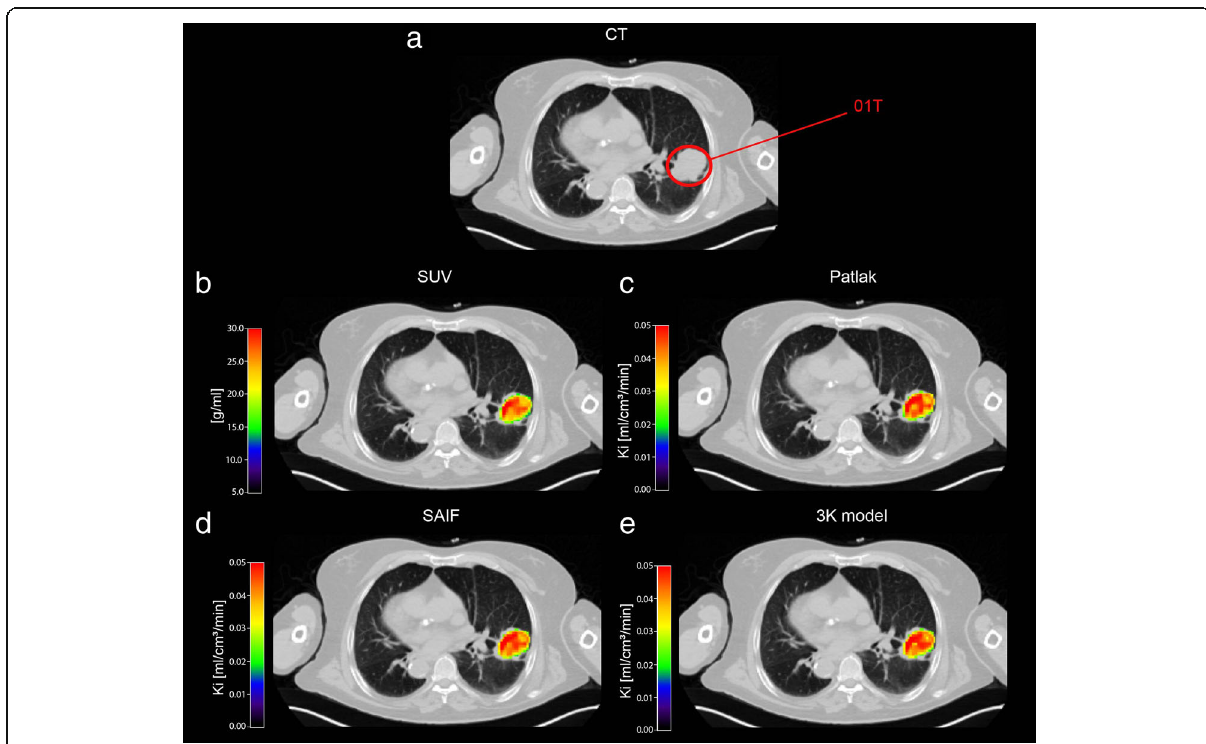
Fig. 3 Parametric maps of SUV and K i in a representative patient. Transaxial thoracic CT image: the primary lung cancer is highlighted by red circle ( a ). Map of SUV within primary lung cancer over-imposed on transaxial thoracic CT image ( b ). Voxel-wise maps of K i obtained with Patlak, SAIF approach and 3K model, respectively, in primary lung cancer over-imposed on transaxial thoracic CT image ( c , d and e ) CT , computed tomography; SUV , standardized uptake value; K i , the fractional uptake of 18 F-FDG; SAIF , Spectral Analysis with Iterative